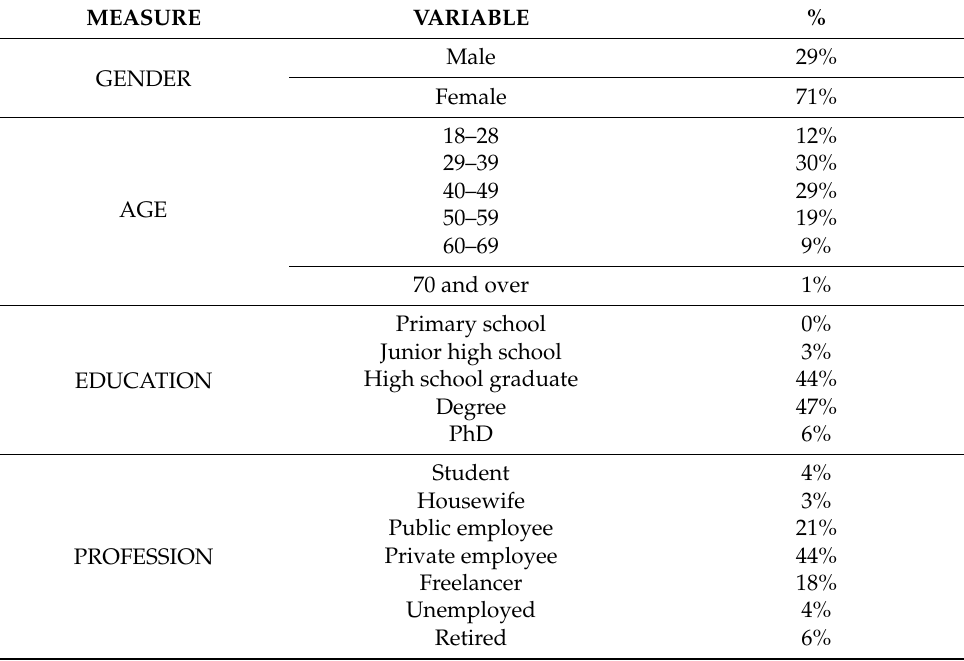
Table 1. Socio-demographic profile of the